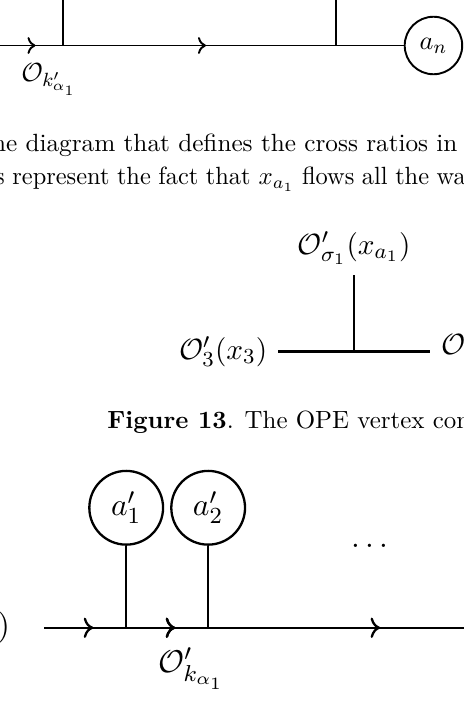
Figure 14 . The ( M − 1) -point conformal blocks where we expand the circle filled with 3 0 in figure 10. Here the arrows represent the fact that x flows all the way to the last vertex on the rightmost 3